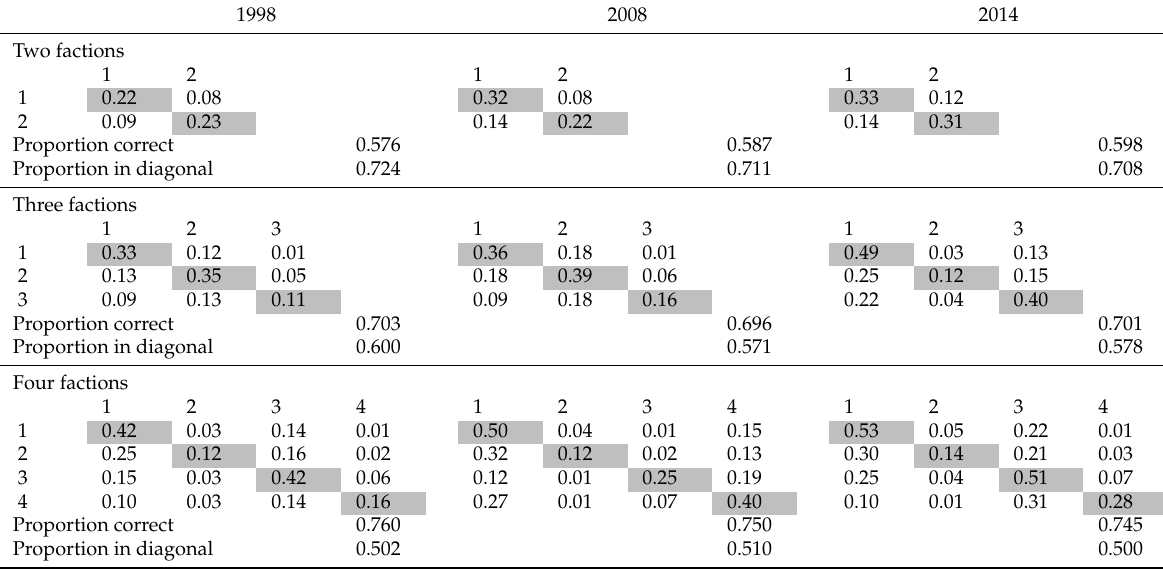
Figure 6: Block model of occupational network with three factions, 1998. Table 5: Density of ties between and within network